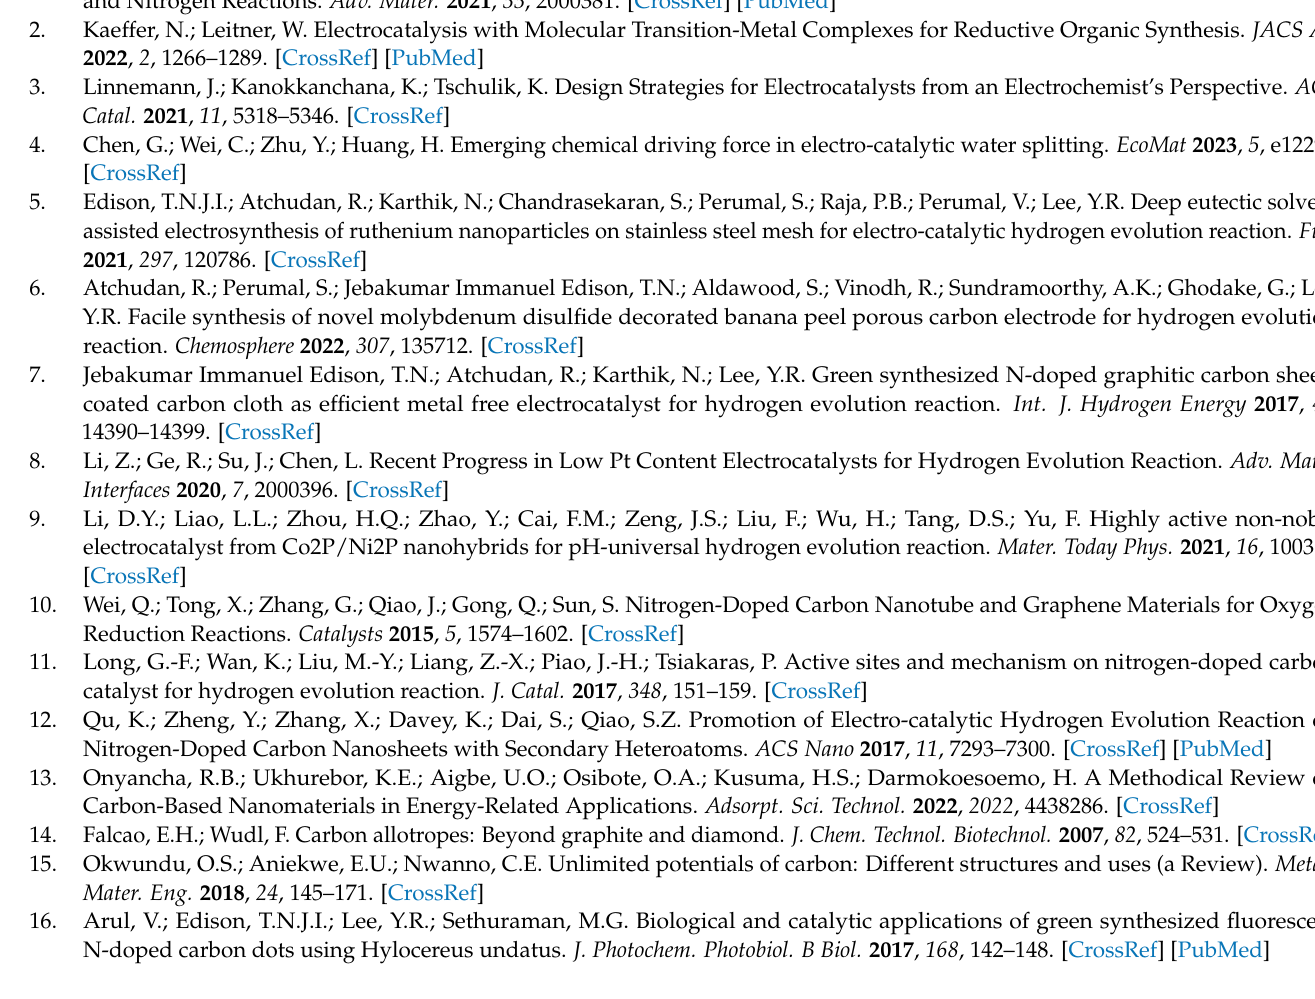
(inset of Pie chart: presented elements with atomic %) of synthesized H-PCM; Figure S4: